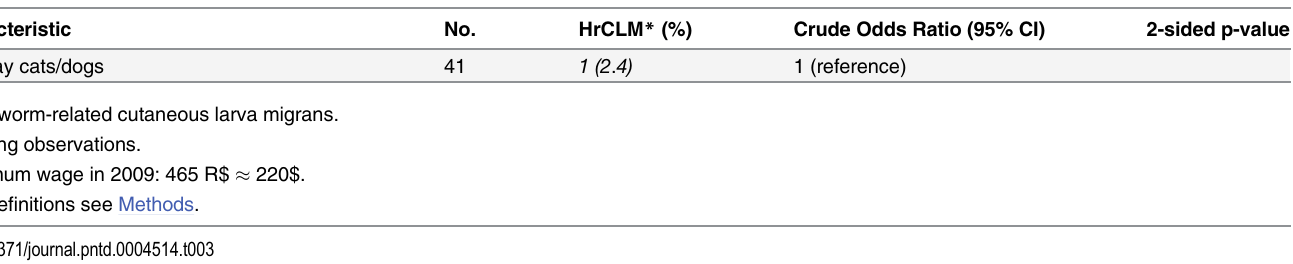
The multivariable model showed a complex pattern of risk factors with walking barefoot on sandy soil being most significant. This corroborates our previous findings from a semi-arid area of Brazil, where the lacking use of footwear was an independent risk factor [23]. For the first time we could show that the odds differed by the frequency protective footwear was used. Participants who always used shoes ran a lower risk of acquiring HrCLM than those wearing shoes sometimes (Table 4). Even the commonly used flip-flops (plastic sandals, which consist of a thin rubber sole with a single string) provided significant protection. However, closed shoes were worn regularly only by seven individuals. Obviously, HrCLM was predominantly acquired outdoors. Neither walking barefoot indoors, even if the floor consisted of sand or soil, nor owning a cat or dog were identified as independent risk factors. Assumedly, animal hookworm larvae were unable to complete the life cycle indoors because the floors were usually dry and accidentally dropped animal excrements were rapidly removed.